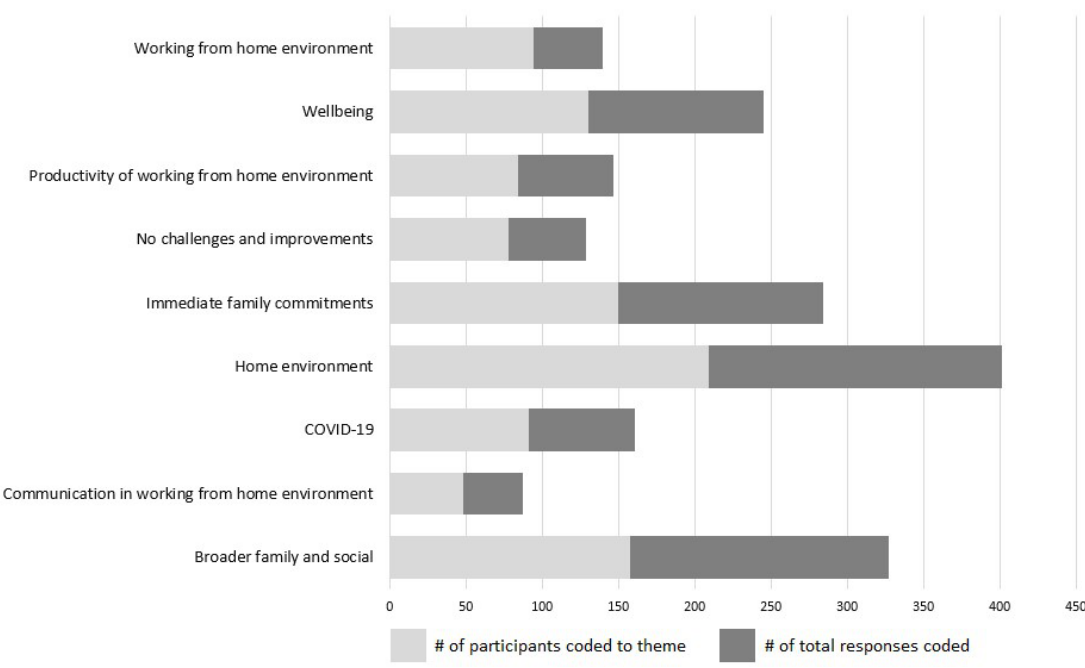
Figure 1. Coding frequency across themes by total participants and number of responses coded.